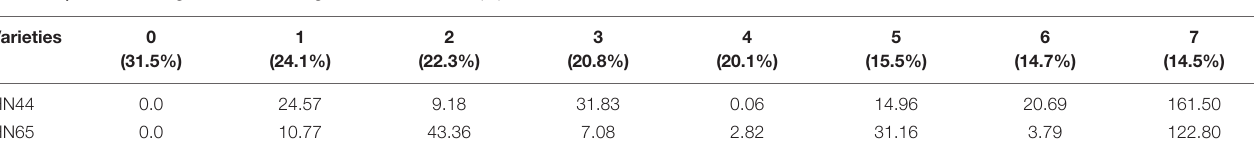
FIGURE 8 | Effect on T-AOC under different soil water contents. Indicates that the values marked with different letters are significantly different, and those marked with the same letter are considered to be statistically insignificant. TABLE 9 | Effect of drought on the relative growth rate of T-AOC